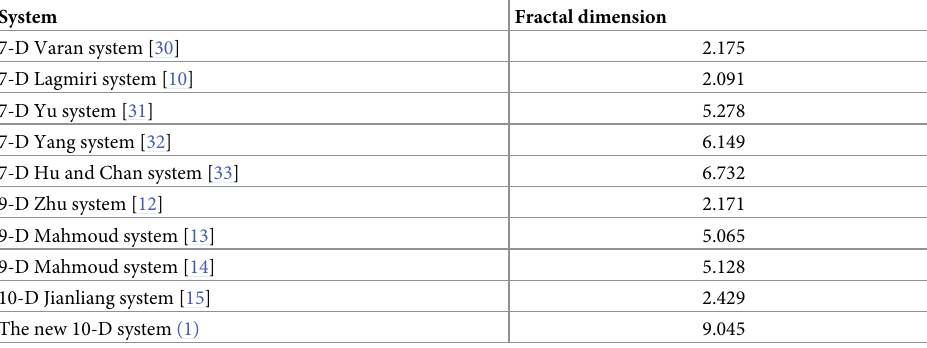
Table 1. Kaplan-Yorke fractal dimension of ten high dimensional chaotic system. System Fractal